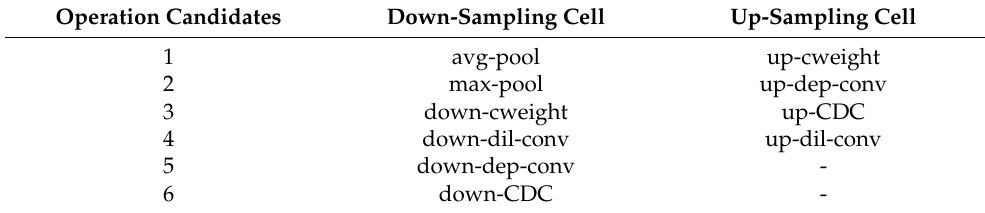
Table 1. Operation candidates for down-sampling cell and up-samping cell.